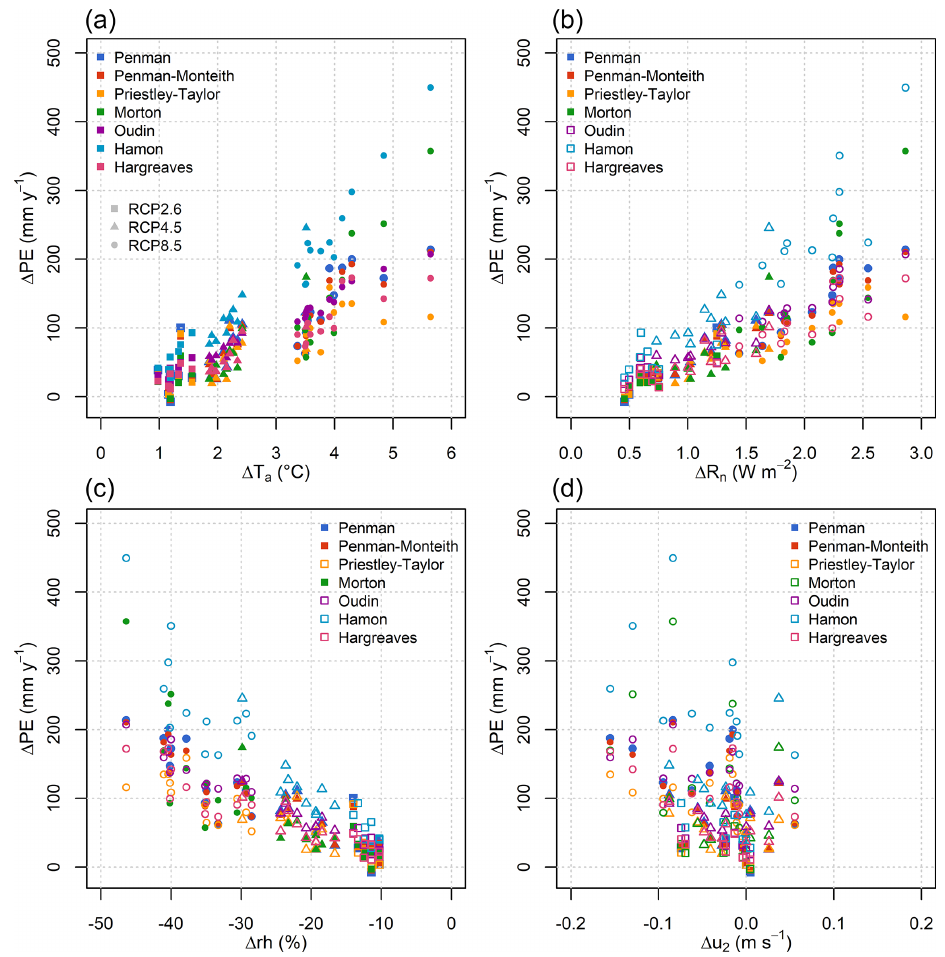
Figure 4. Mean anomalies of annual PE compared to the average anomalies of the climate variables by the end of the century (2070–2099) for air temperature ( T a , a ), net radiation ( R n , b ), relative humidity (RH, c ) and wind speed ( u 2 , d ). Each symbol represents one combination of RCP–GCM–RCM–PE formulation. Full symbols are used when the climate variable is used in the PE formulation, and blank symbols are used when the climate variable is not used in the PE